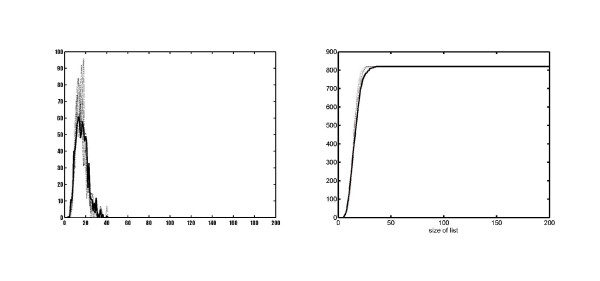
Histogram for exon cg3201 3. Distribution of similar words for the exon cg3201 3 of Drosophil a (solid line) compared to the histograms of the randomly shuffled versions (dotted lines) in direct (left) and cumulative (right) forms. The X axis shows the size of lists of similar words, the Y axis is the number of lists.